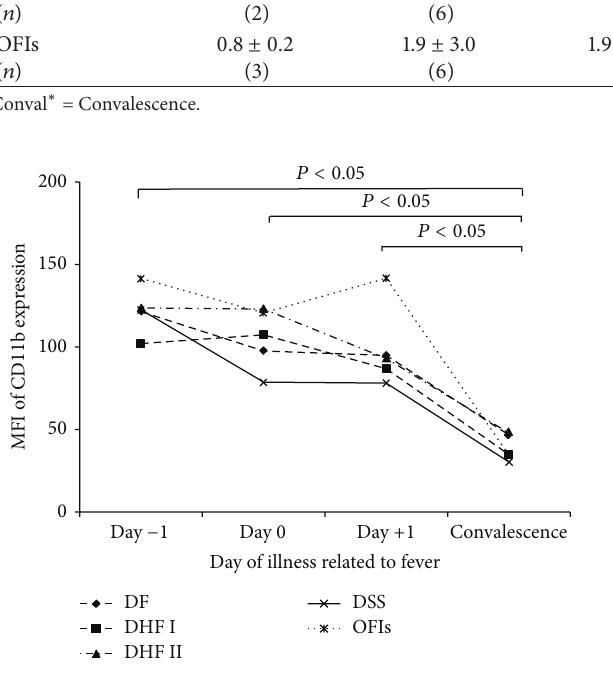
Figure 3: The mean fluorescence intensity (MFI) of surface CD11b expression on the surface of monocytes in DF, DHF grades I and II, DSS, and OFIs patients, followed by the day of illness related to fever (unit as a.u. or arbitrary units of fluorescence).